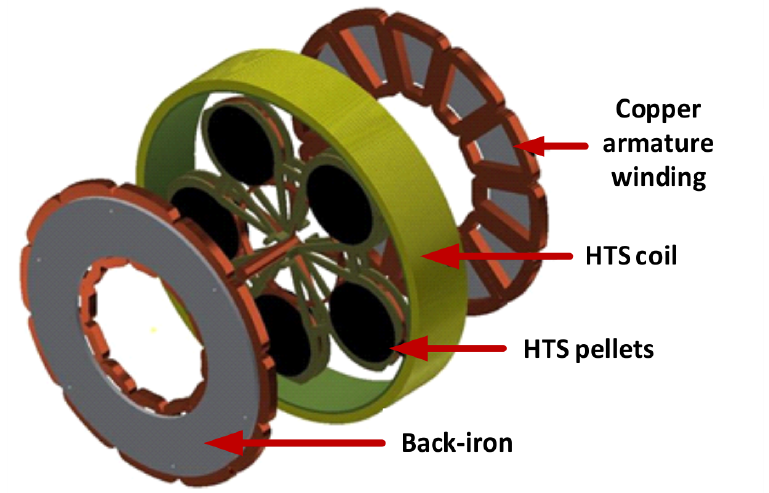
Figure 8. Concept of axial-flux partially HTS machine from [46], licensed under CC BY